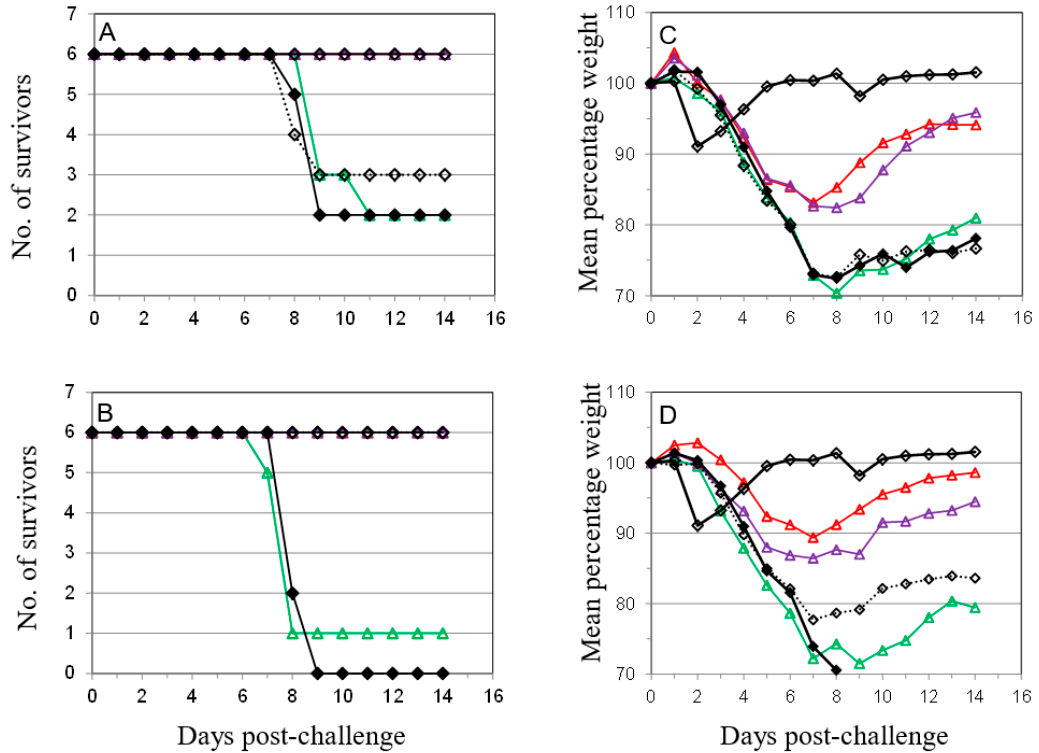
Figure 6. Protection of animals by passive transfer of Mabs. Anti-A27 ( ), anti-B5 ( ) or both